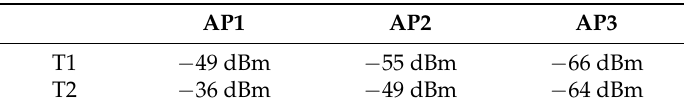
Figure 5. Experiment of ACS in the real environment, APs are shown as red circle dots, two test points is shown as blue crosses, and the five points are in one straight line. Table 3. The RSSIs of ACS test points.